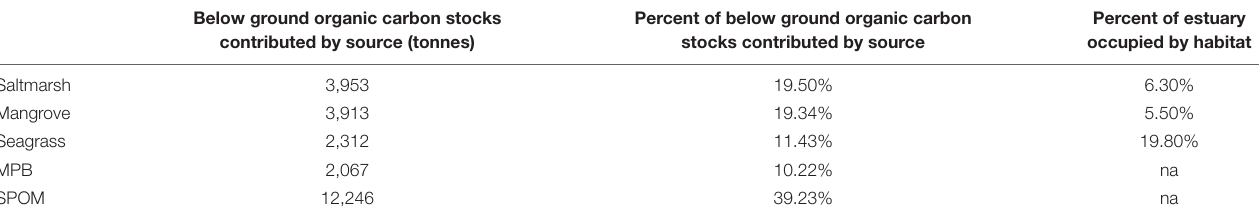
TABLE 4 | Estimated organic carbon stocks (100 cm depth) contributed by each organic matter source (adjusted by habitat area and carbon source analysis). Below ground organic carbon stocks contributed by source